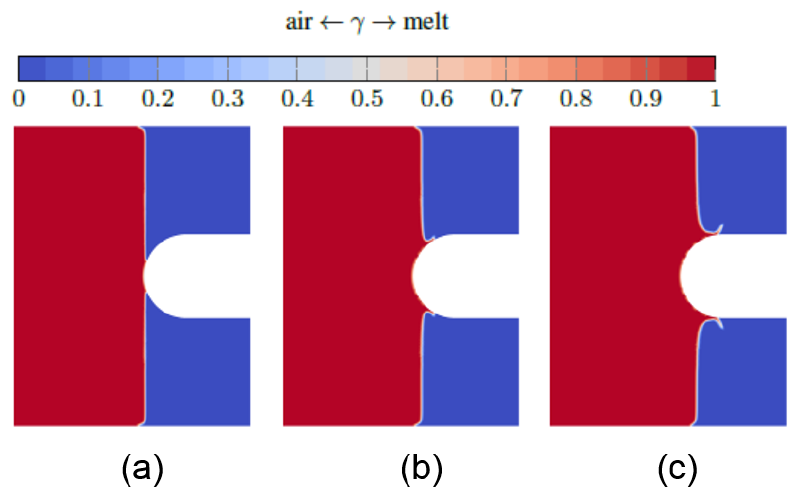
Figure 5. Phase distribution of the melt at impact and immediately afterwards: (a) t · U 0.205; (c) t · U = 0.21. Here, U = U in with U in = 20 ms − 1 . R